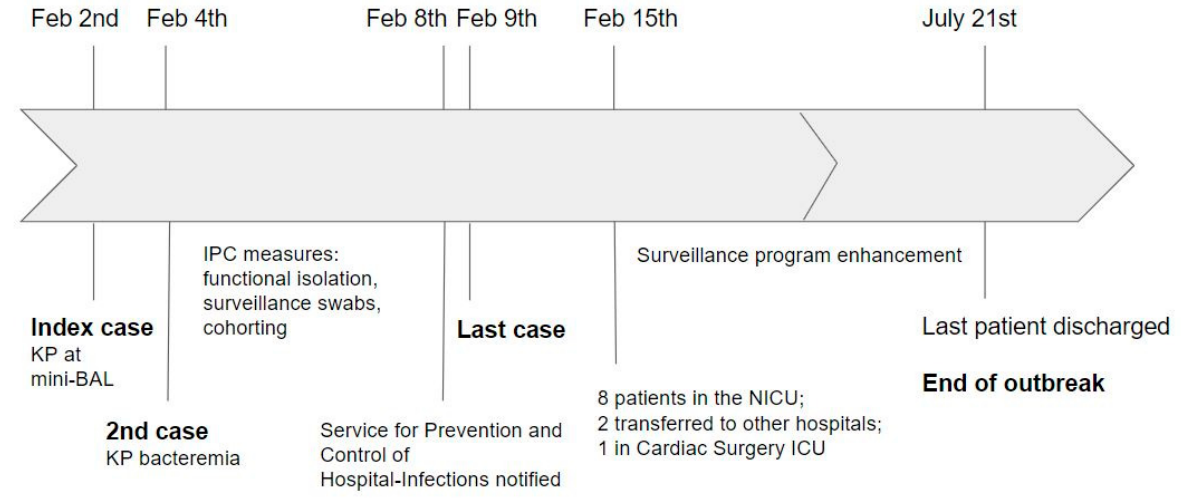
Figure 1. Outbreak timeline.